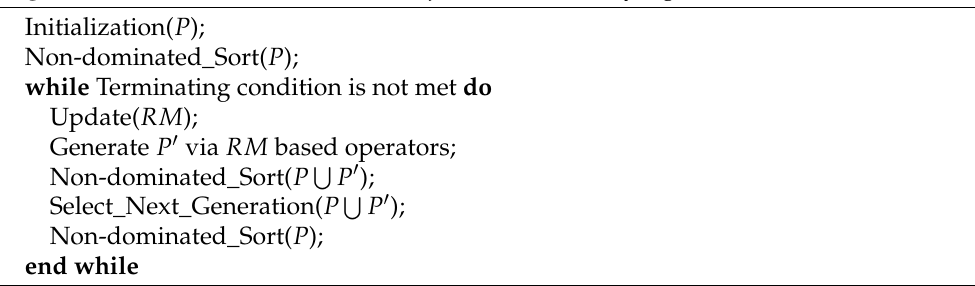
Algorithm 1 The framework of multi-objective evolutionary algorithm with relevance